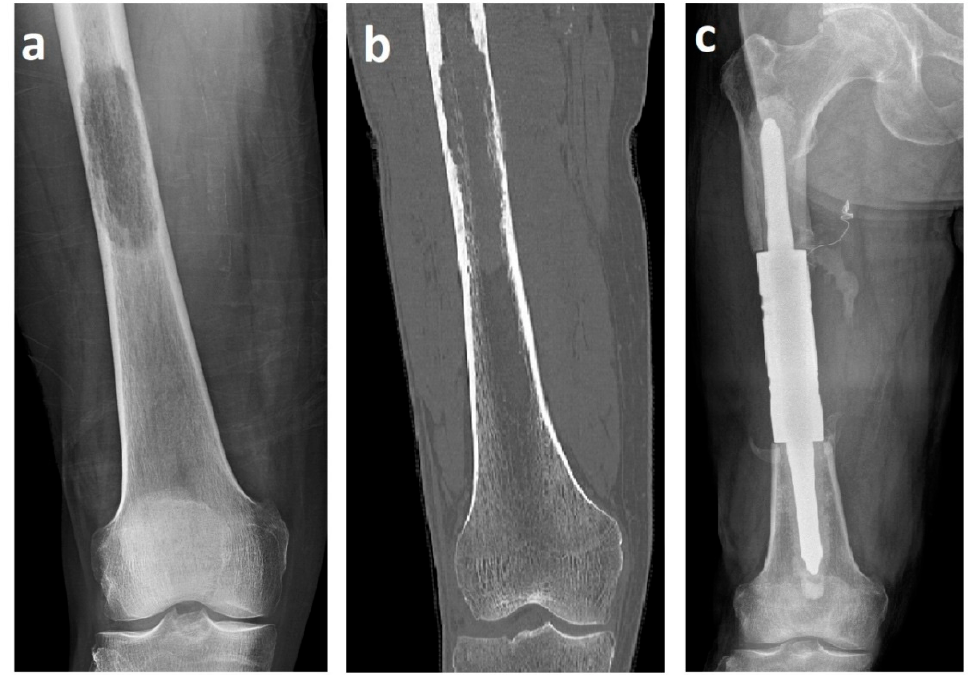
Figure 1. X-ray ( a ) and computed tomography ( b ) images of renal cell carcinoma solitary metastasis to the femoral diaphysis. X-ray image ( c ) after resection with a cemented intercalary endoprosthesis. These images are from patient 2 in Table 1.